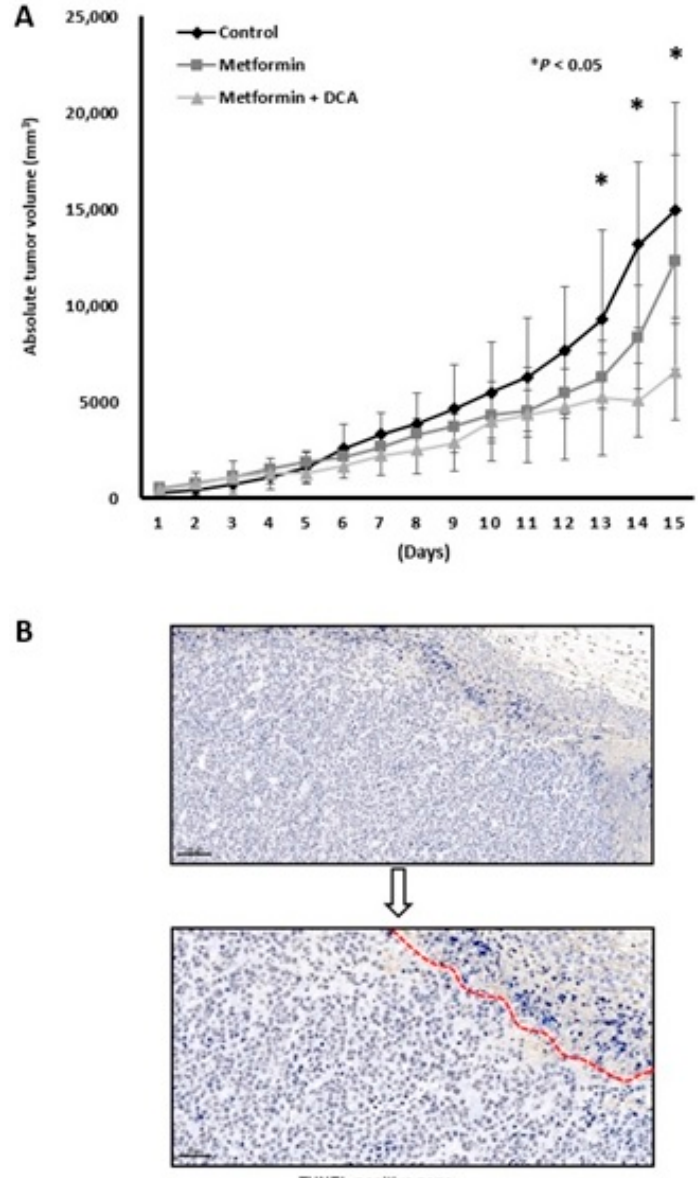
Figure 6. Anticancer effects of a combination treatment with metformin and DCA in a mouse model bearing MH-134 cells. ( A ) Tumor volume in the combination treatment group at 13–15 days was significantly smaller than that in the control or metformin treatment groups (all, p < 0.05). ( B ) In the combination treatment group, tumor tissues showed TUNEL-positive staining (400× magnification). * p <